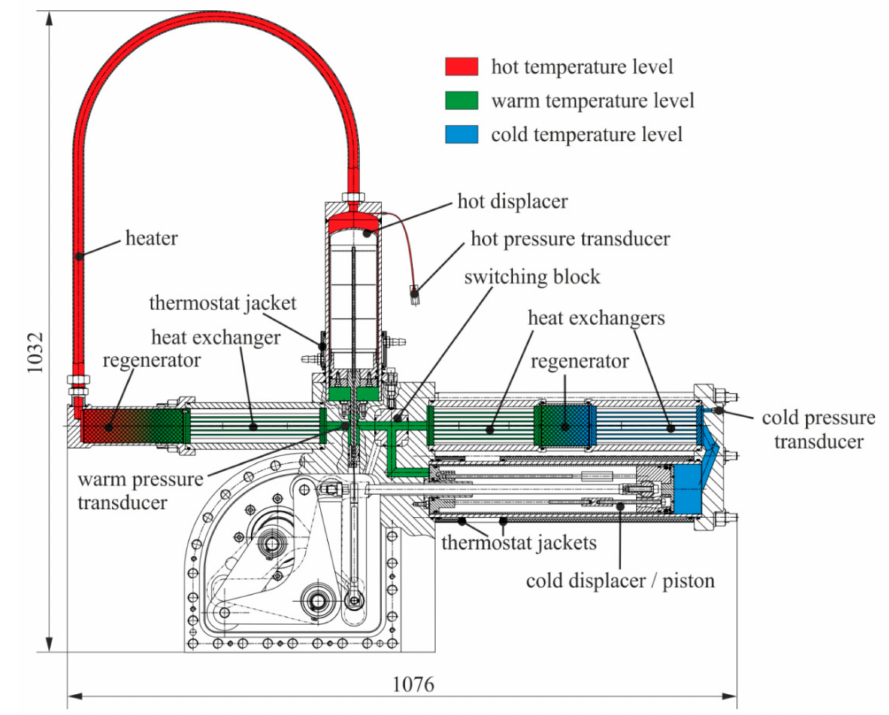
Figure 1. Cross-section of the laboratory-scale machine without fine-wire thermocouple